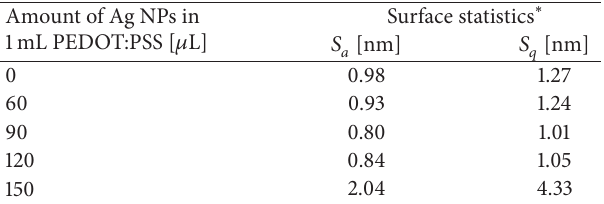
Table 1: The surface parameters of PEDOT:PSS:Ag NPs layers. Amount of Ag NPs